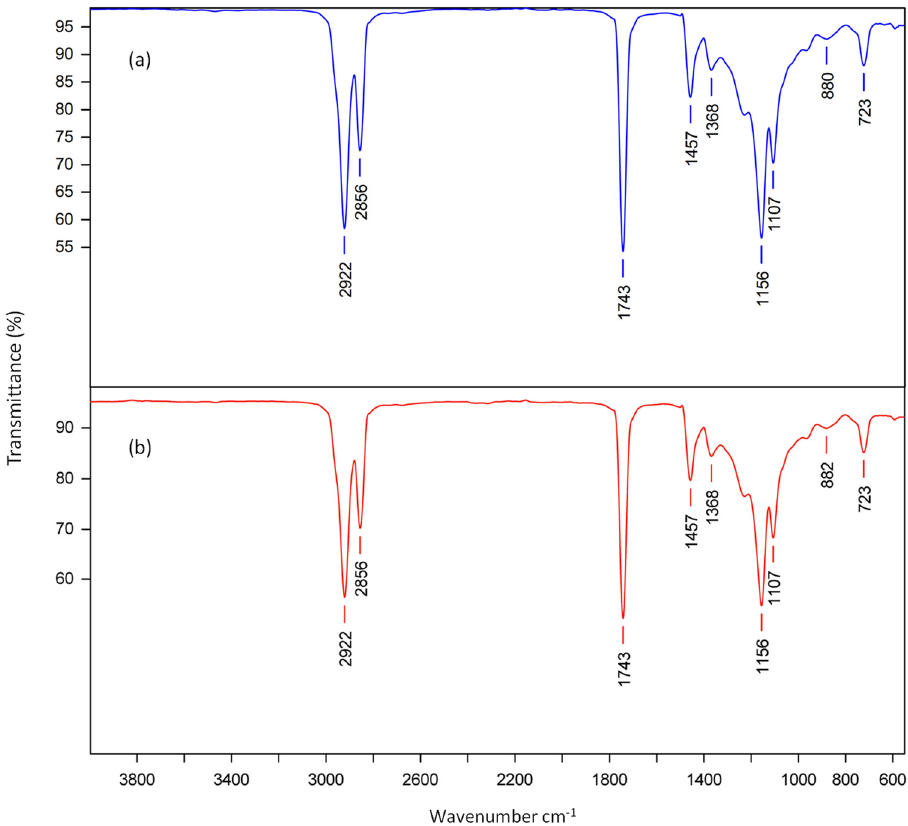
Figure 11. FTIR for ( a ) Moringa oleifera oil mixture and ( b ) Aegle marmelos oil mixture. ATR spectra for herbal oil mixture 1 ( Moringa oleifera , curry leaf and coconut oil) and mixture 2 ( Aegle marmelos , curry leaf and coconut oil) the assignments were similar (2922 cm − 1 O–H stretching (alcohol); 1742 cm − 1 C–H bending; and 1157 cm − 1 C–O–H stretching).